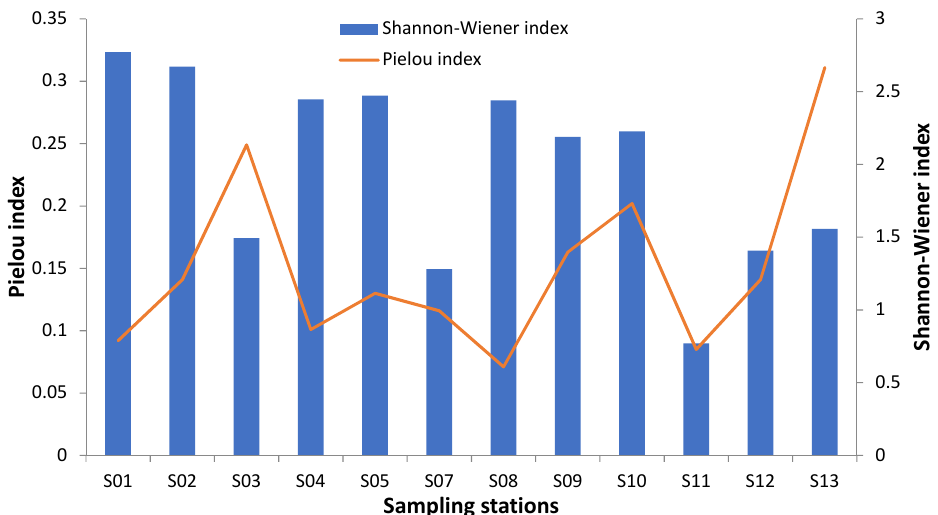
Figure 4. Shannon ‐ Wiener index and Pielou index of benthic fauna for the different sampling sta ‐ Figure 4. Shannon-Wiener index and Pielou index of benthic fauna for the different sampling tions.